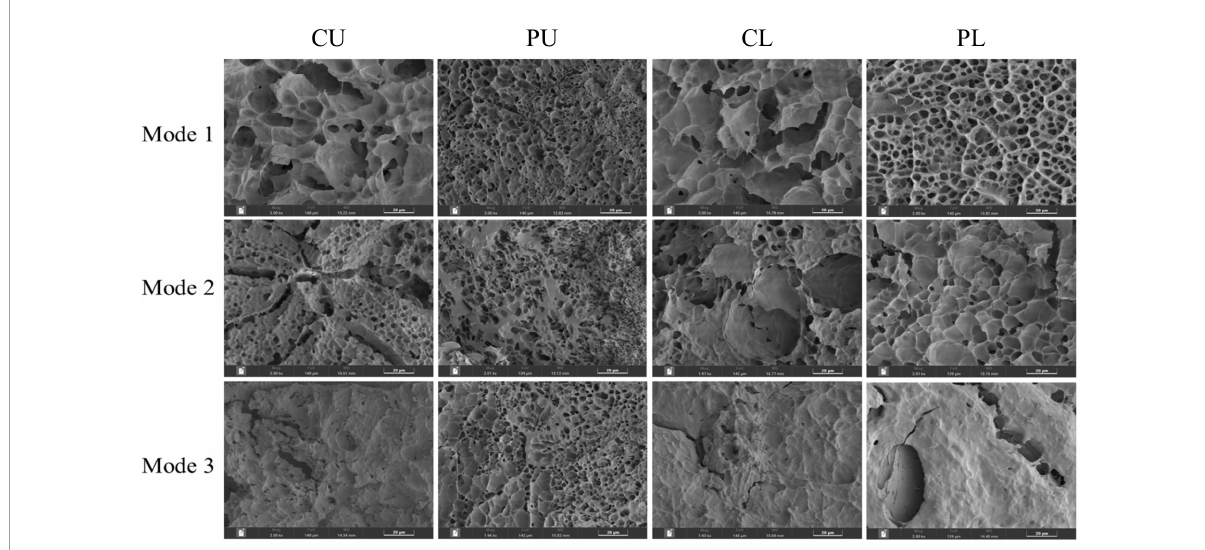
FIGURE4 Morphological structure of the center of cooked rice cross-sections under different heating